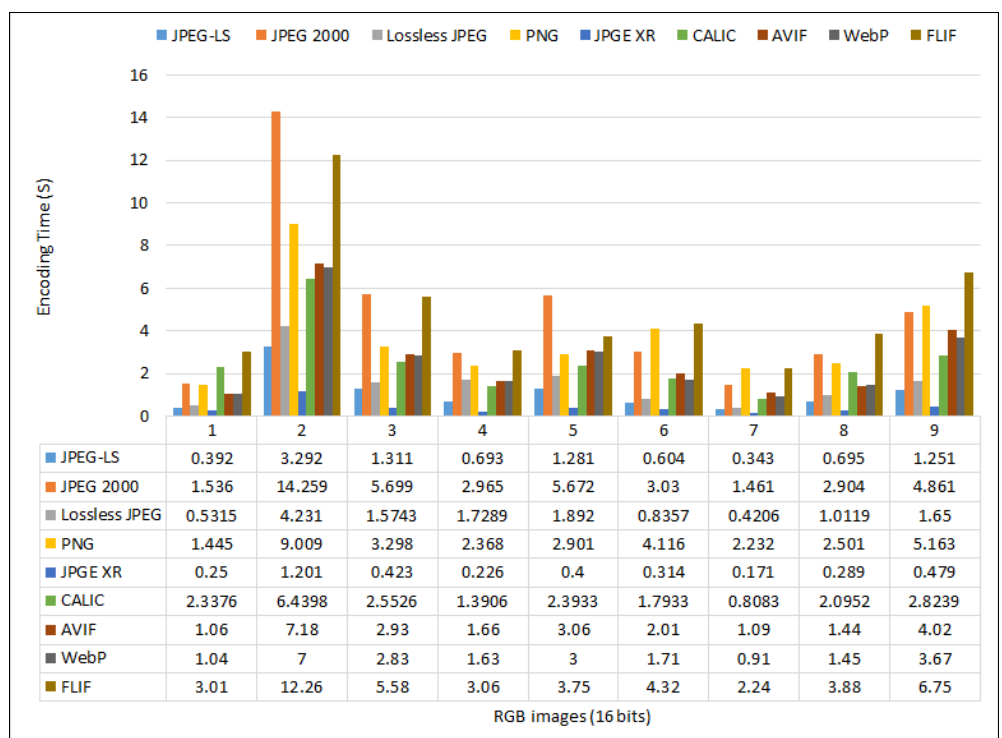
Figure 24. Comparison of encoding times for 16-bit RGB images.